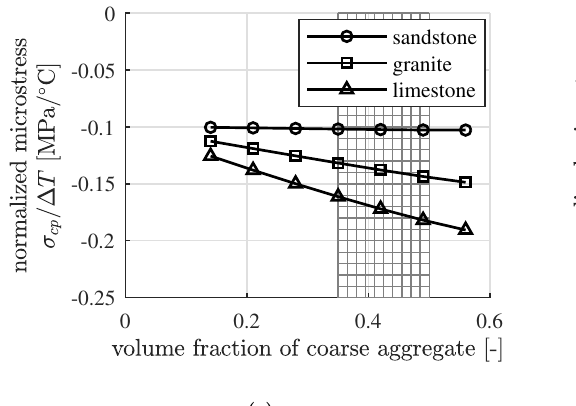
Figure 7. Dependence of the microstresses in ( a ) the cement paste and ( b ) the ITZs, surrounding the coarse aggregates, on the type and the volume fraction of the coarse aggregates, for concrete with RH = 50%, f cp = 0.30 and w / c = 0.40.